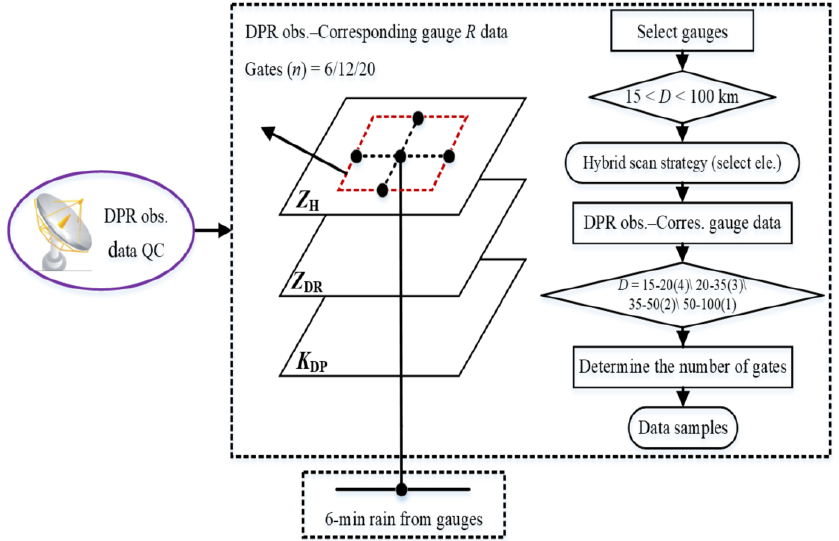
Figure 2. Construction of data samples for machine learning. D is the distance from the automatic weather stations to the radar; (4), (3), (2), and (1) represent the fourth, third, second, and first scan elevation angles of the radar, respectively.